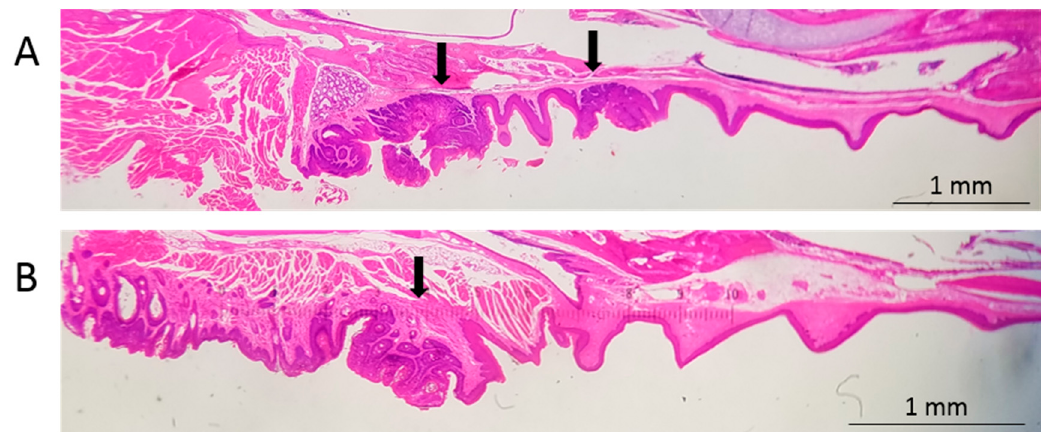
Figure 2. Infection of the soft palate with mouse papillomavirus (MmuPV1) elicits tumors. ( A ) A sagittal cross-section of the maxilla of a nude mouse collected 14 weeks after infection with 10 8 genome equivalents of MmuPV1. Soft and hard palate tumors are indicated with arrows. ( B ) The maxilla of an NOD scid gamma (NSG) mouse collected 21 weeks after infection with 8 × 10 9 genome equivalents of MmuPV1. The soft palate tumor is indicated with an arrow.